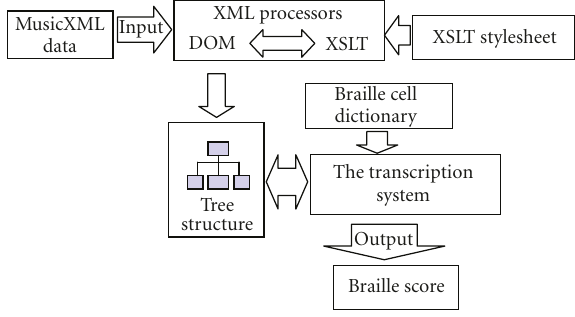
Figure 5: The configuration of the transcription system.